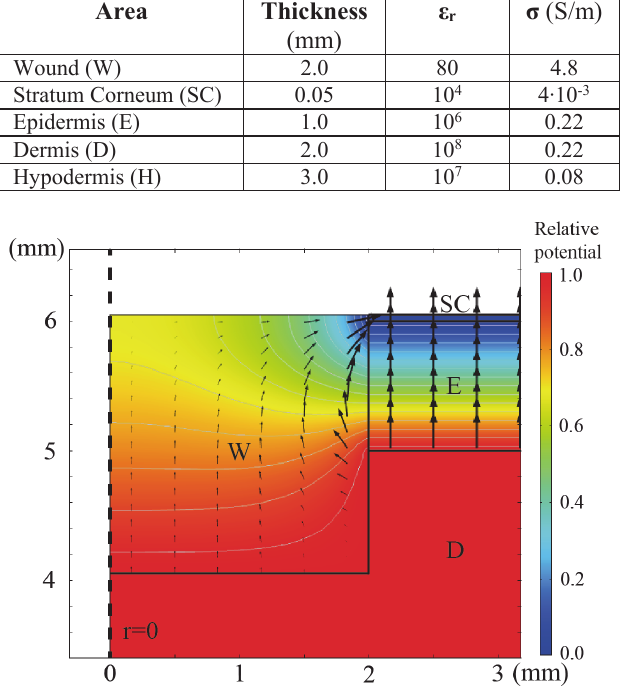
Fig.4: Calculated electrical field around a wound (W) without any wound dressing present [17]. We see a cross-section along the radius of a circular representation of the wound. Notice how the electric field is directed towards the wound in its lower part. At the top of the wound it points in the other direction. The colors represent the electric potential according to the scale to the right, in units of the trans-epithelial potential which exists over the extent of the epidermis. Typically the red color is around 40 mV negative. There is a vanishingly small penetration of the field into dermis and hypodermis (not shown) owing to their large dielectric permittivities. The field strength in the epidermis is typically of the order of 10 V/m. Notice that the extension of the region which is influenced by creating a wound is of the order of millimeters.